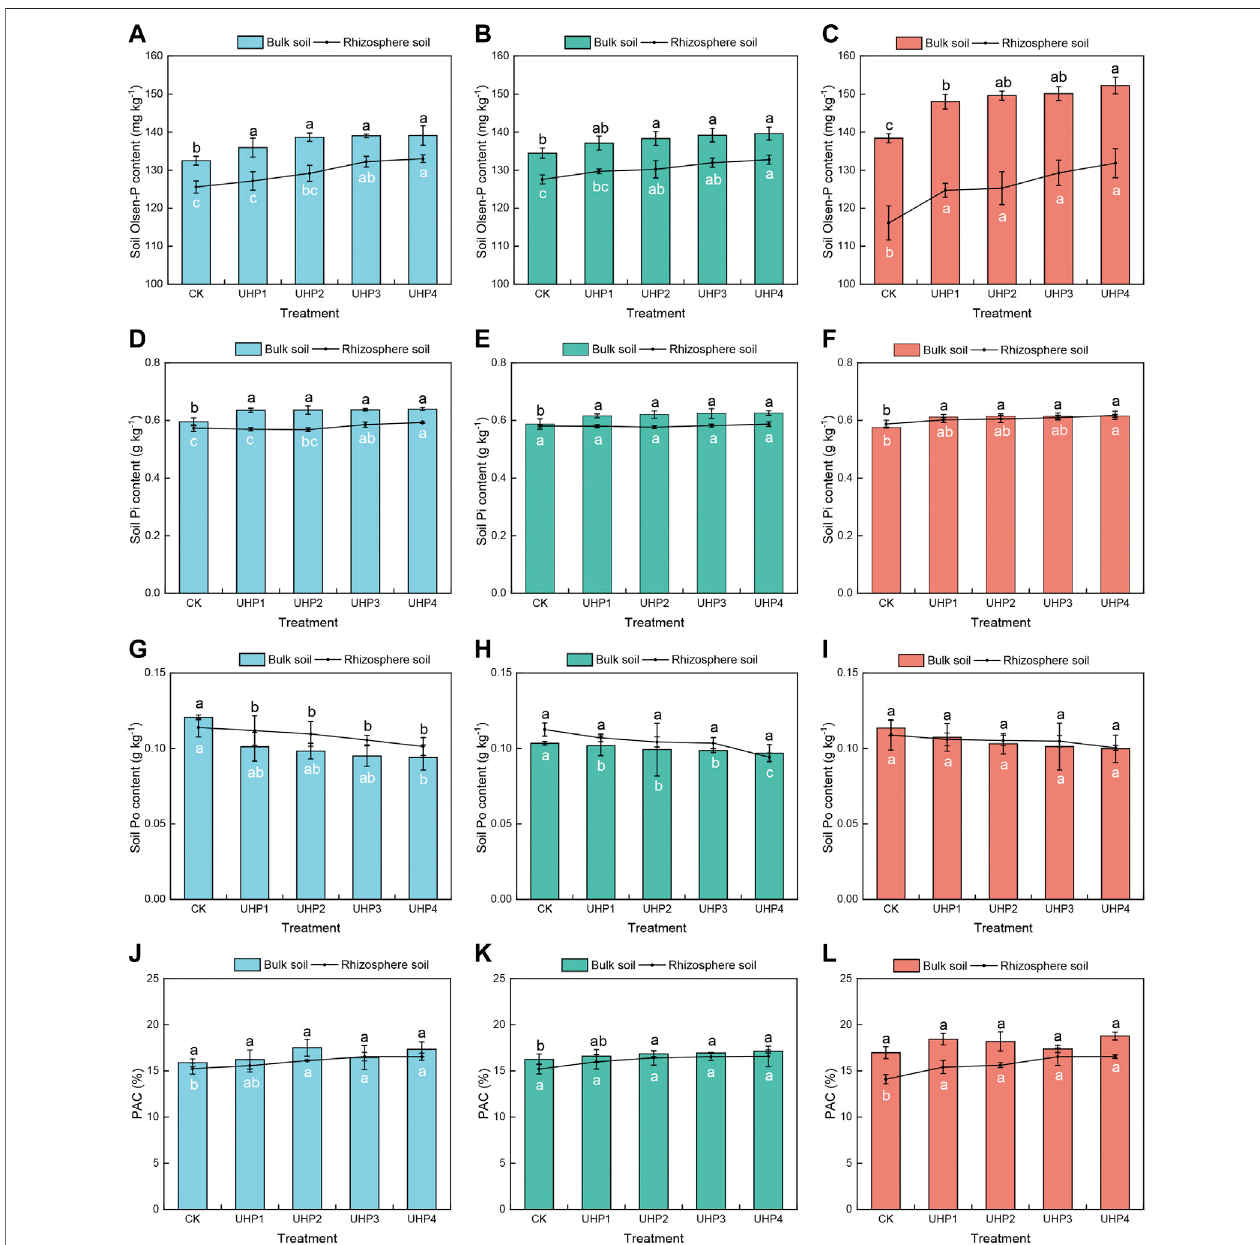
FIGURE 5 | Effects of aeration on the P turnover of amaranth rhizosphere soil and bulk soil at different growth stages. (A) Soil Olsen-P content at 20 days, (B) soil Olsen-P content at 30 days, (C) soil Olsen-P content at 45 days, (D) soil inorganic P (Pi) content at 20 days, (E) soil Pi content at 30 days, (F) soil Pi at 45 days, (G) soil organic P (Po) content at 20 days, (H) soil Po content at 30 days, (I) soil Po at 45 days, (J) P activation coef fi cient (PAC) at 20 days, (K) PAC content at 30 days, and (L) PACat45 days.Blacklettersrepresentsigni fi cantdifferencesinbulksoil,whilewhitelettersrepresentrhizospheresoil.Barsindicatemean±SD.Differentletterson the bars indicate a signi fi cant difference between different